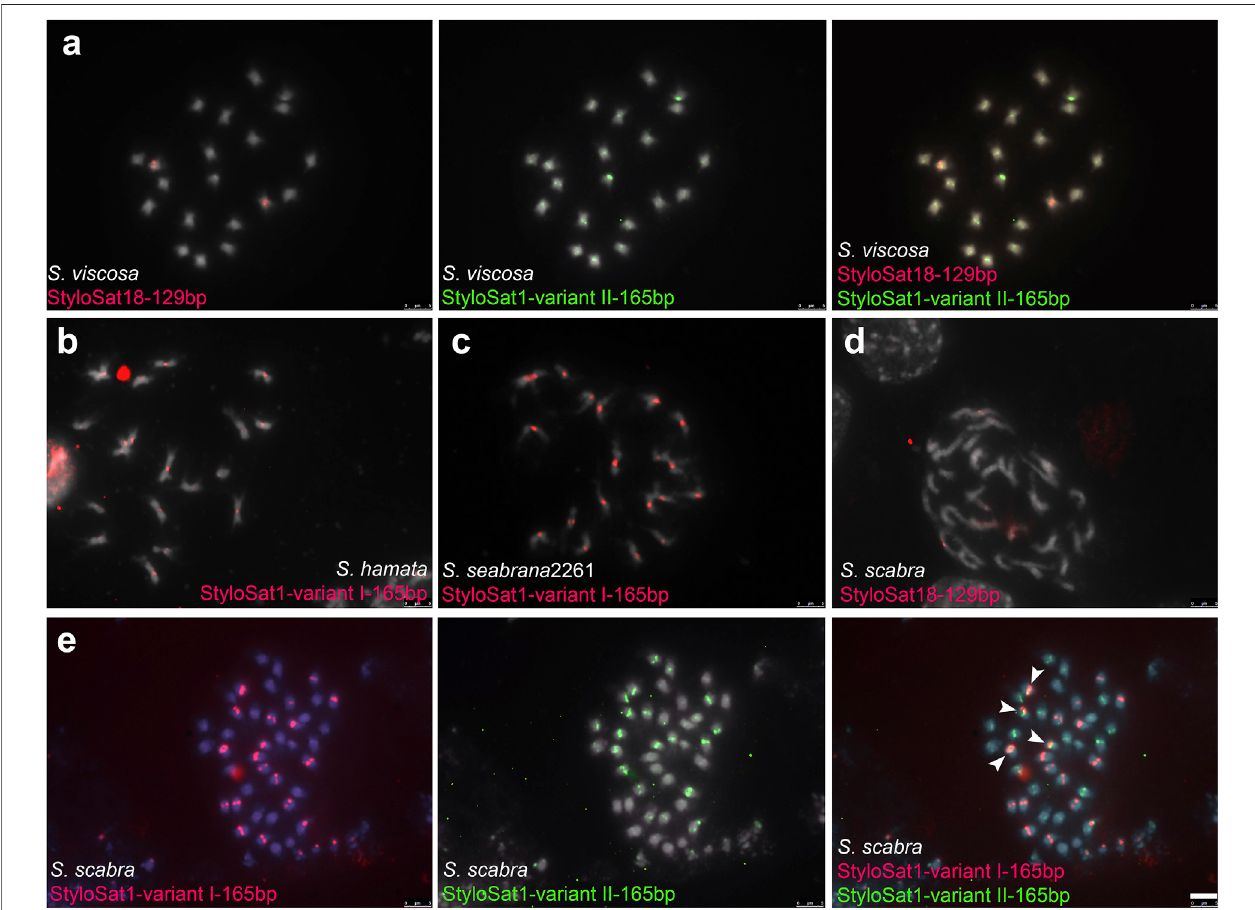
FIGURE 7 | FISH in Stylosanthes scabra complex. (A) FISH in S . viscosa with S . viscosa -speci fi c satDNA repeats StyloSat18-129bp and StyloSat1-variant II- 165bp.FISHin S . hamata (B) and S . seabrana (C) with S . hamata/seabrana -speci fi csatDNArepeatStyloSat1-variantI-165bp.FISHin S . scabra withStyloSat18-129bp (D) and with StyloSat1-variant I-165bp and StyloSat1-variant II-165bp (E) satDNA repeats. Bar (cid:1) 5 μ m.